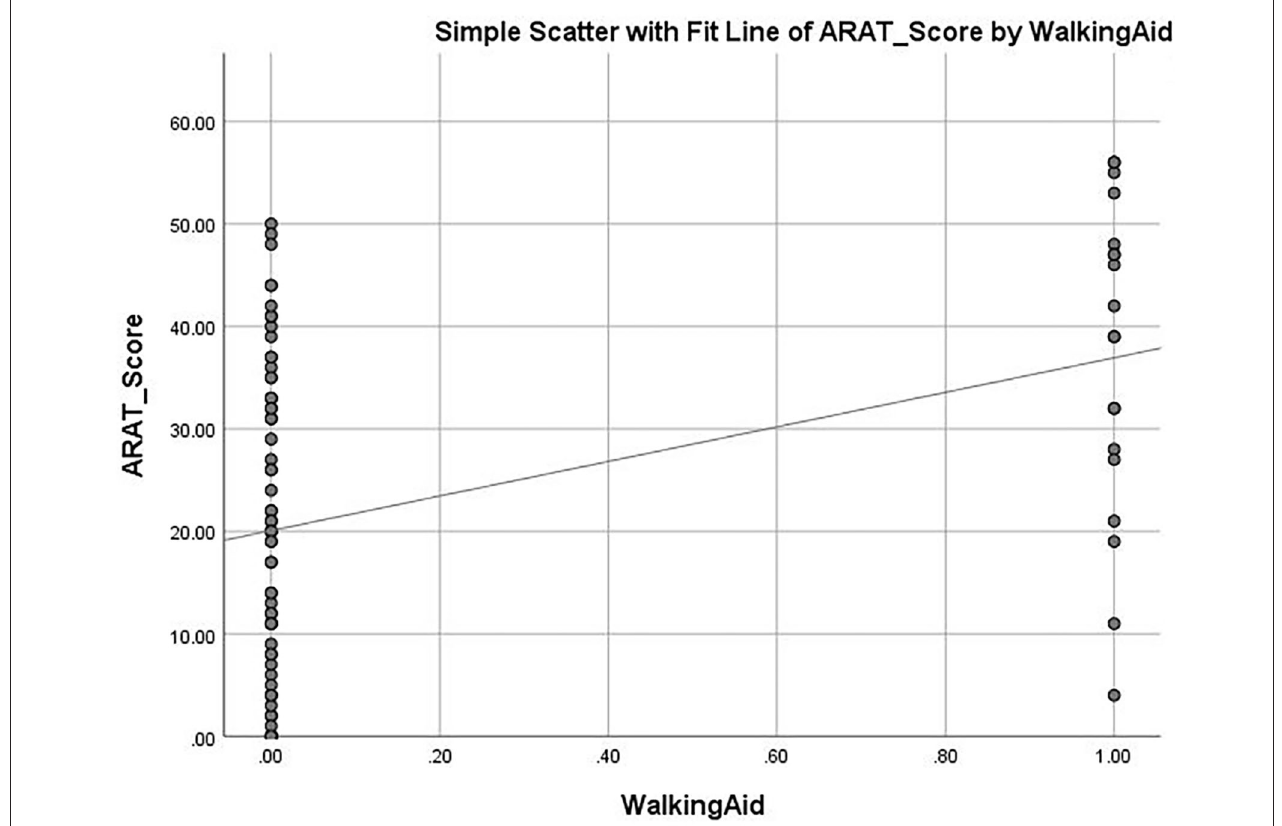
FIGURE 1 | The correlation between ARAT score and the use of walking